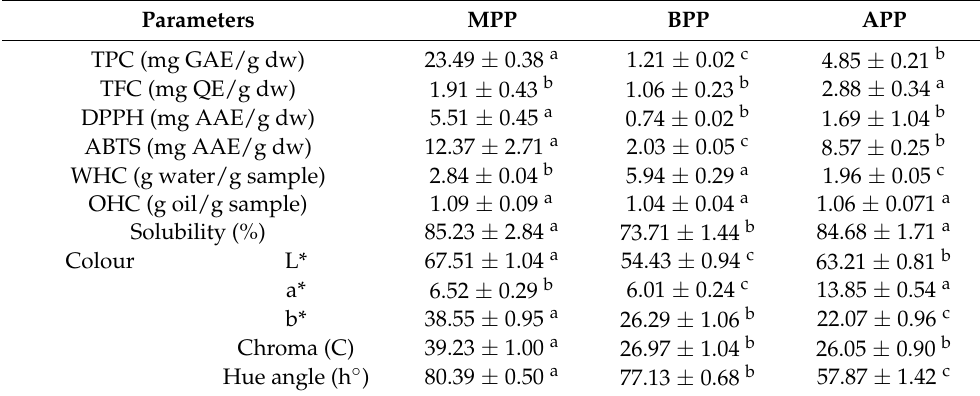
Results of antioxidant potential, functional properties and color analyses of fruit peel powders.